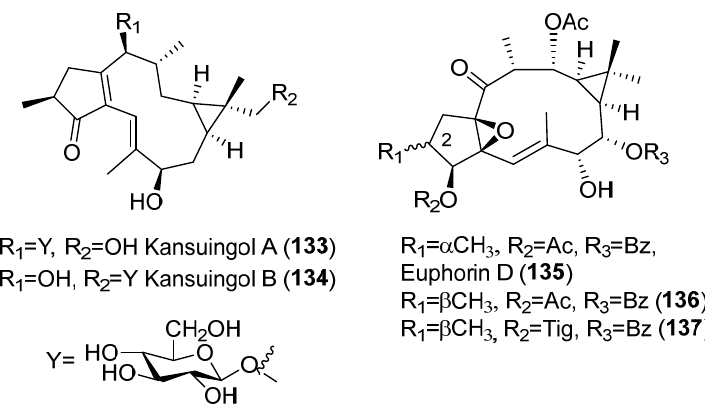
Figure 23. Structure of compounds 133 – 137 .